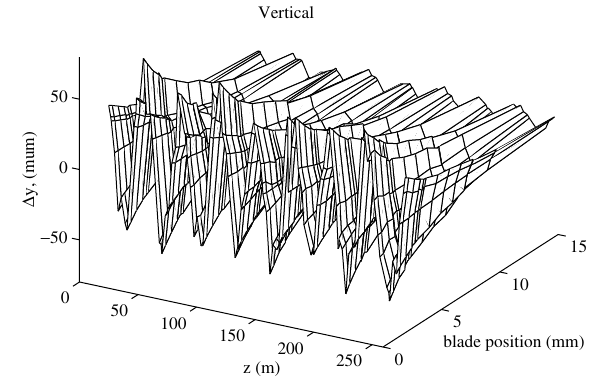
FIG. 11. Vertical orbit deviation versus scraper blade position.